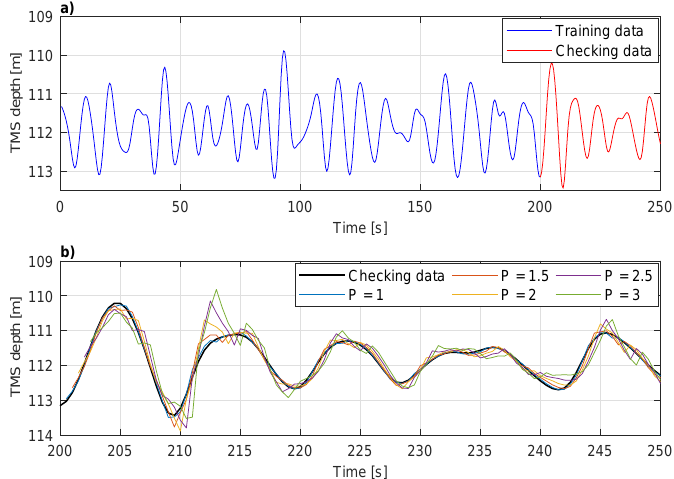
Figure 7. Dataset used for ANFIS evaluation. ( a ) First 200 s of data is used for a training, while 50 s of data is used for checking. ( b ) Performance of ANFIS predicting TMS depth between 1 s and 3 s in future compared to checking